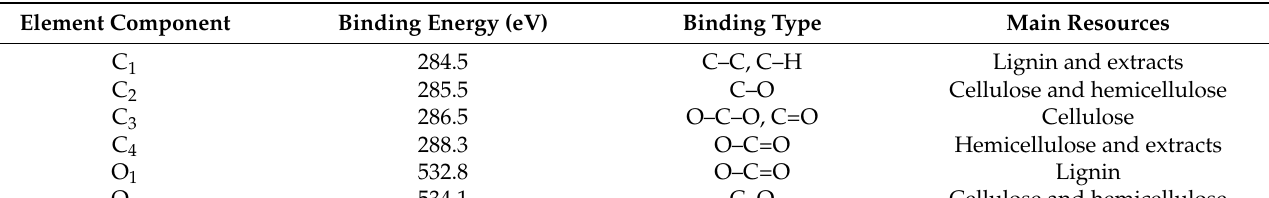
Table 2. Classification of carbon (C) and oxygen (O) peak components of bamboo [32–35].